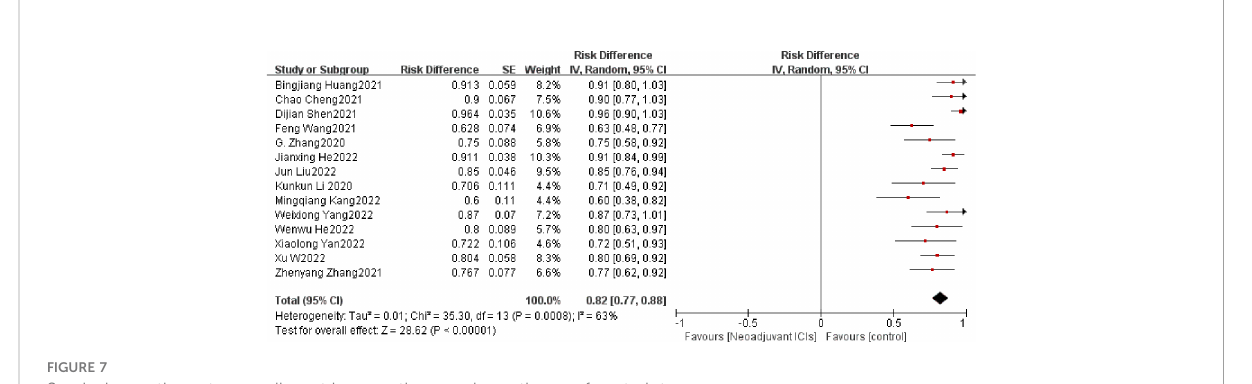
FIGURE 7 Surgical resection rate neoadjuvant immunotherapy chemotherapy forest